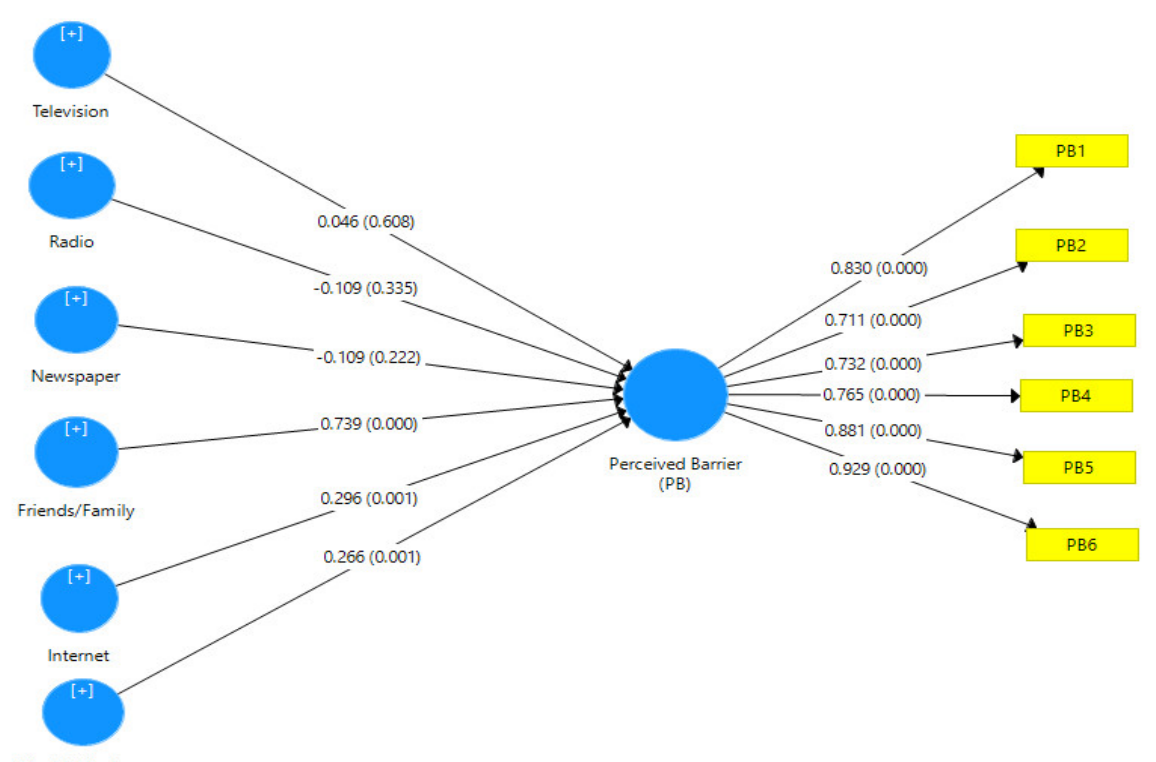
Figure 3. Information sources and perceived barriers of women towards breast self-examination model.